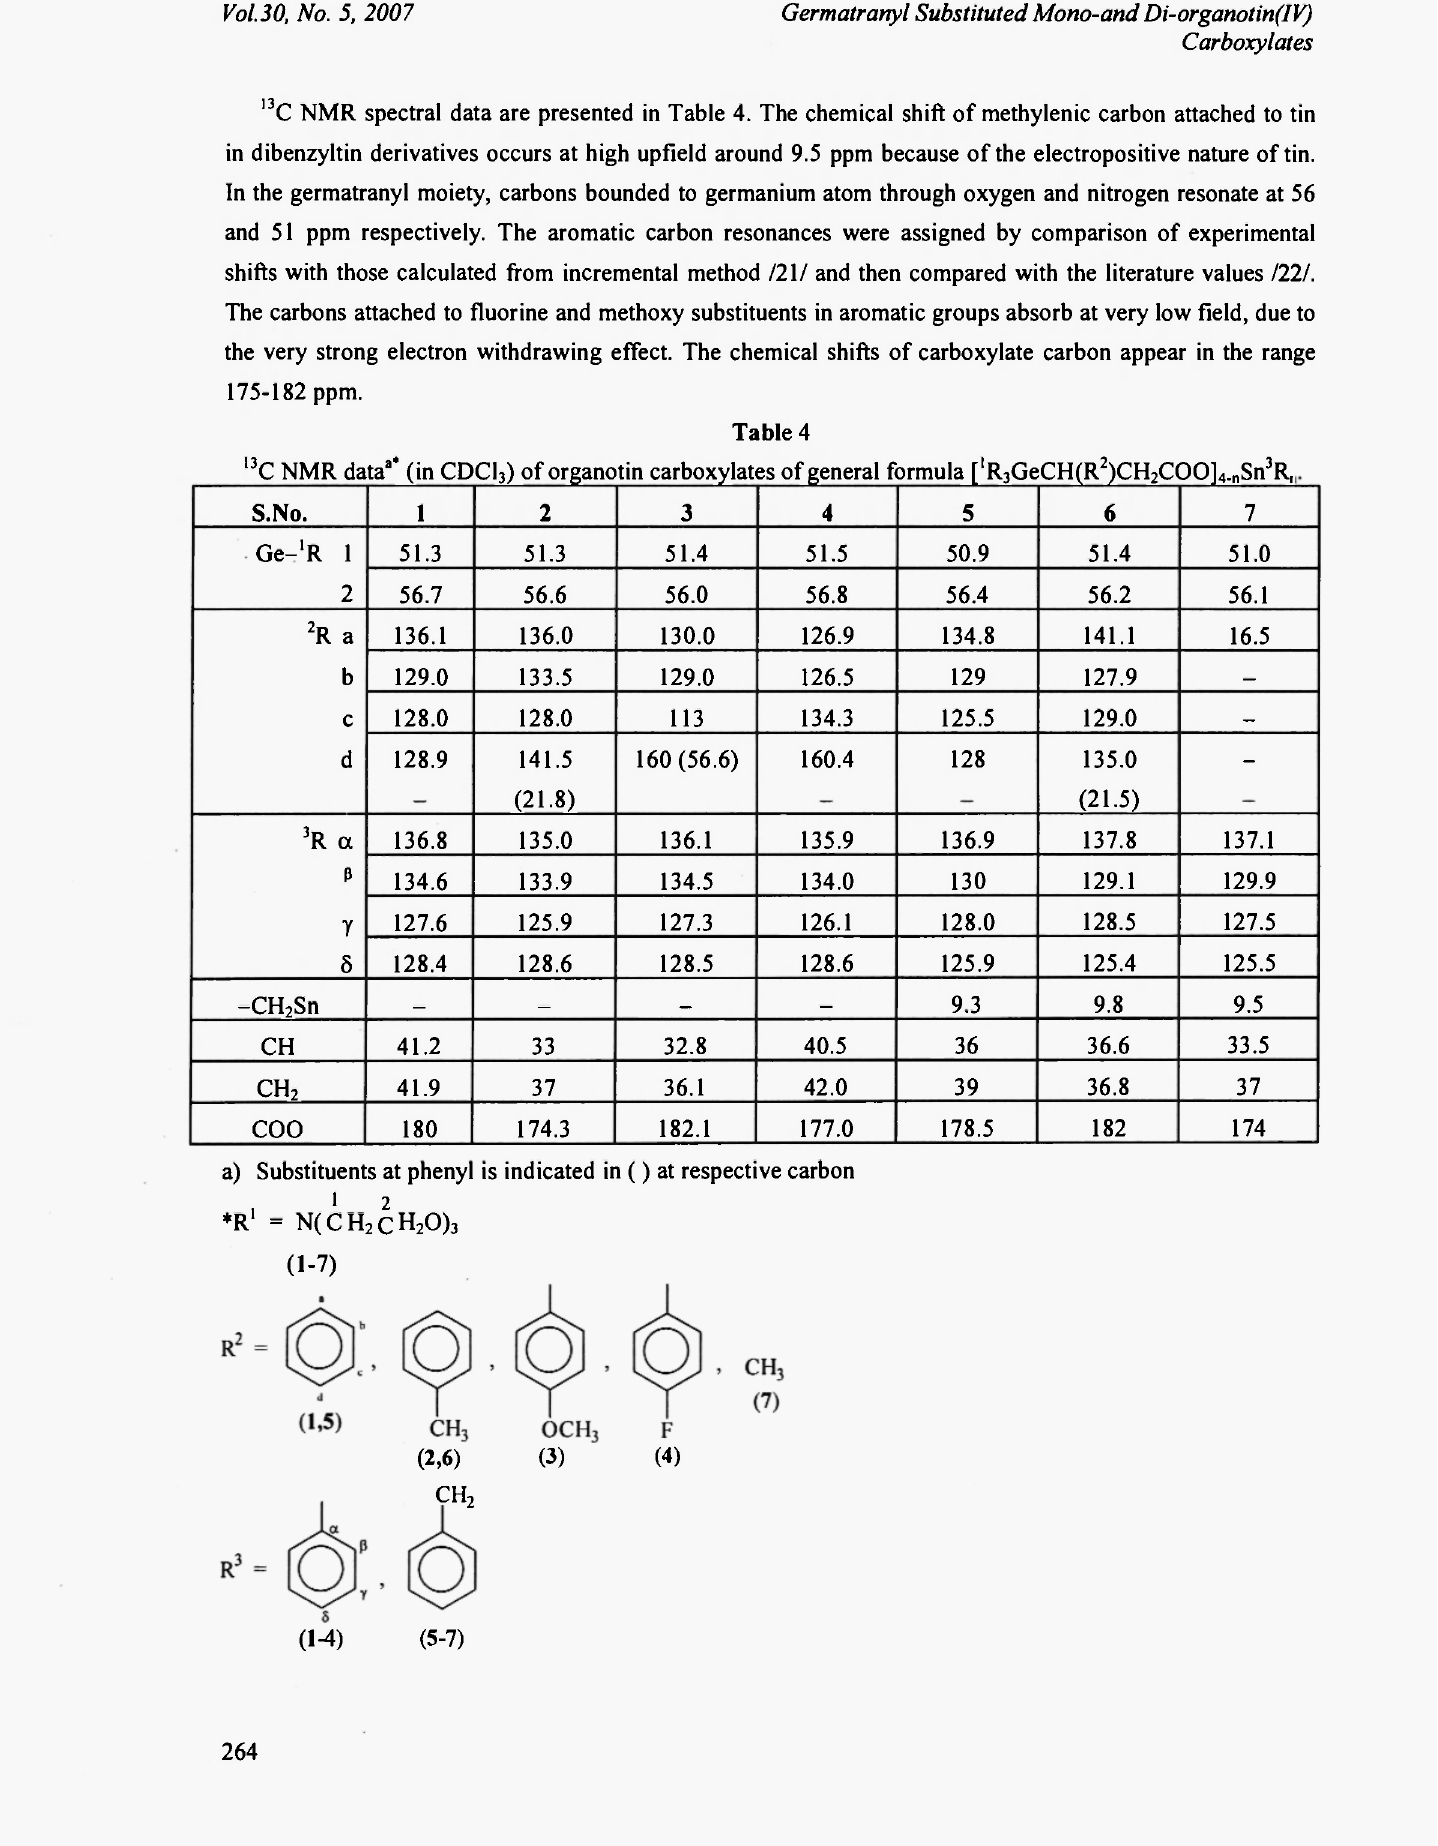
l R3GeCH(R 2 )CH 3 R, 2 COO]4. n Sn